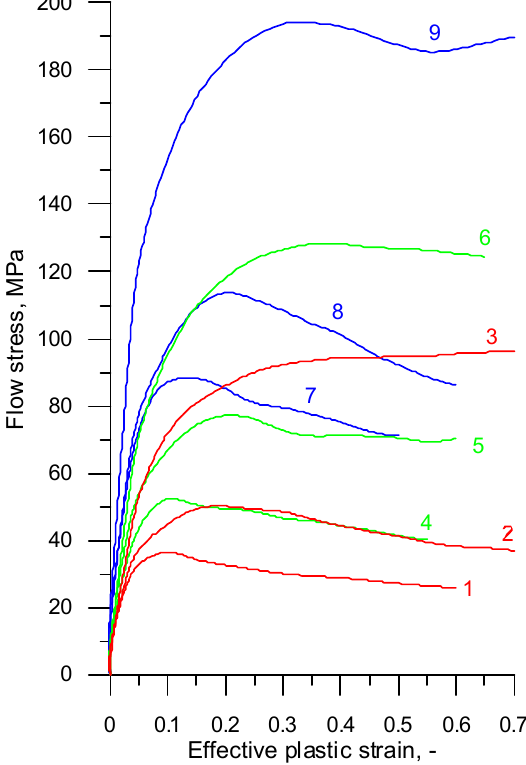
. Figure 1. Experimental flow curves for R200 steel, where 1— T = 1200 ◦ C, ε = 0.1 s − 1 ; 2— T = 1200 ◦ C, Figure 1. Experimental flow curves for R200 steel, where 1— T = 1200 °C, ε(cid:4662) = 0.1 s − 1 ; 2— T = 1200 °C, . . . . ε(cid:4662) = 1 s − 1 ; 3— T = 1200 °C, ε(cid:4662) = 10 s − 1 ; 4— T = 1100 °C, ε(cid:4662) = 0.1 s − 1 ; 5— T = 1100 °C, ε(cid:4662) = 1 s − 1 ; 6—T = 1100 ε = 1 s − 1 ; 3— T = 1200 ◦ C, ε = 10 s − 1 ; 4— T = 1100 ◦ C, ε = 0.1 s − 1 ; 5— T = 1100 ◦ C, ε = 1 s − 1 ; . . . ε = 0.1 s − 1 ; 8— T = 1000 ◦ C, ε = 1 s − 1 ; 9— T = 1000 ◦ C, ε = 10 s − 1 ; 7— T = 1000 ◦ C, 6—T = 1100 ◦ C, °C, ε(cid:4662) = 10 s − 1 ; 7— T = 1000 °C, ε(cid:4662) = 0.1 s − 1 ; 8— T = 1000 °C, ε(cid:4662) = 1 s − 1 ; 9— T = 1000 °C, ε(cid:4662) = 10 s − 1 . . ε = 10 s − 1